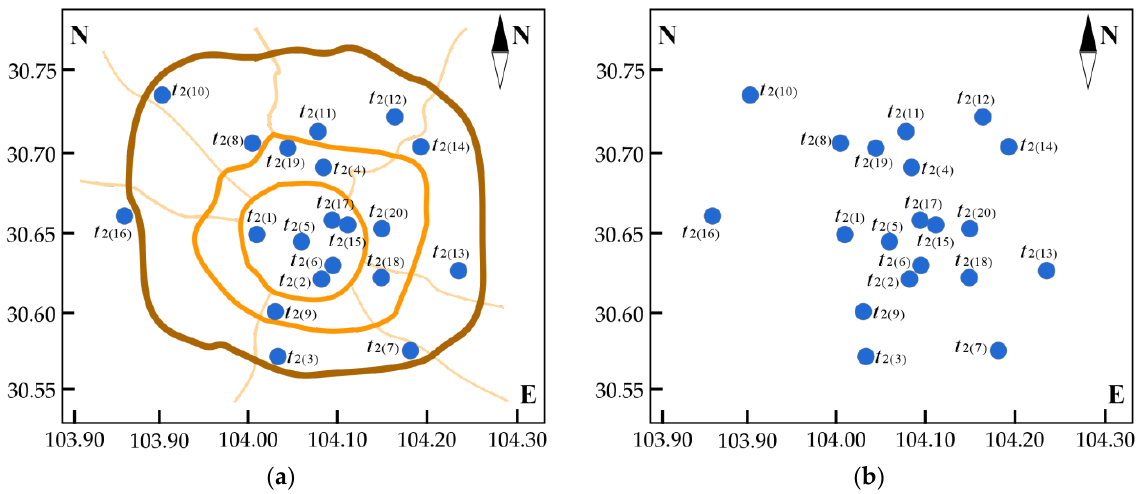
Figure 3. The distribution of the sampled water scenic spots and the extracted scattered dots. ( a ) is the sampled water scenic spots distribution. ( b ) is the extracted scattered dots. Table 1. Water scenic spot evaluation parameter.